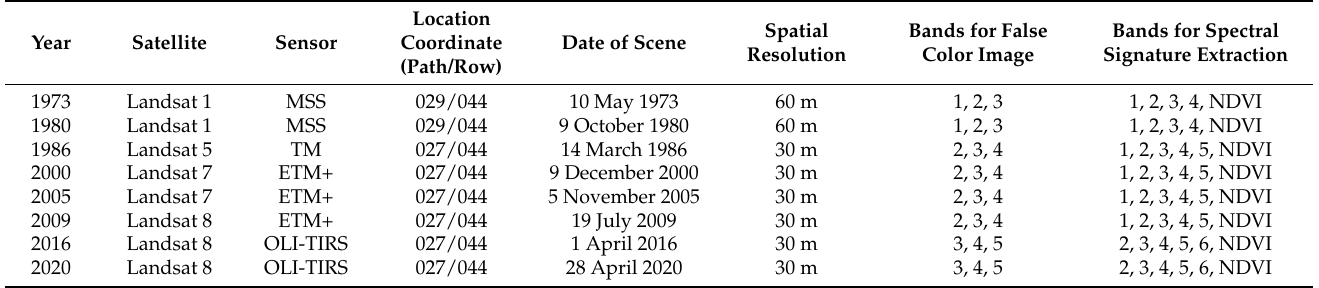
Table 1. Characteristics of Landsat scenes and some parameters used for the analysis of changes in rangeland cover and land use in the Tamaulipan Highlands, Tamaulipas,